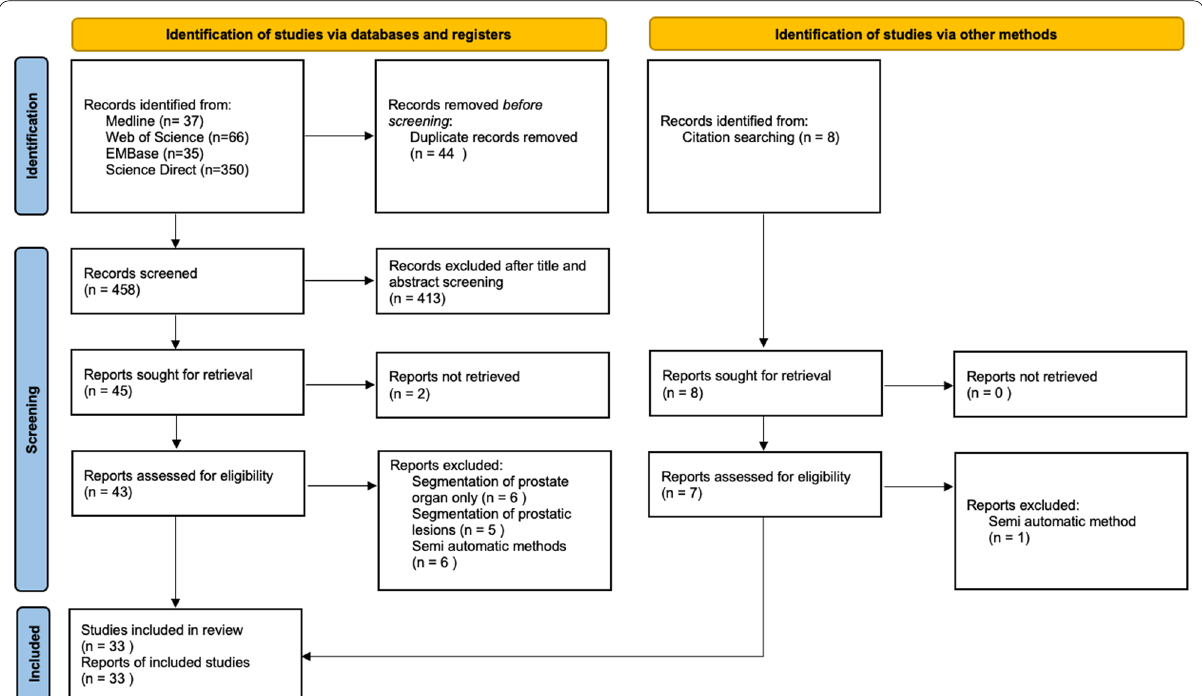
Fig. 1 Flow diagram based on Preferred Reporting Items for Systematic Reviews and Meta‑Analyses (PRISMA) recommendations for